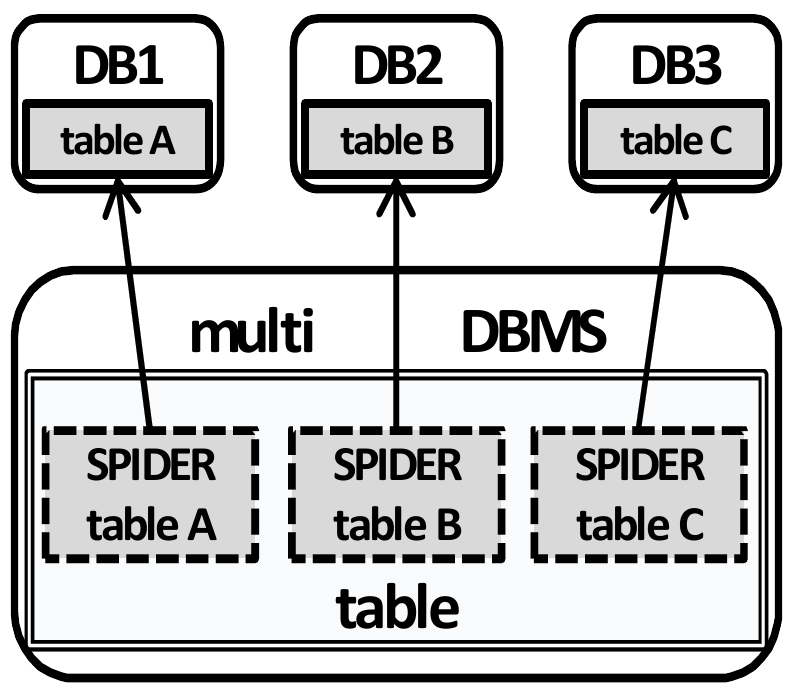
Fig. 4. a structure of multi-database system using the SPIDER storage engine.